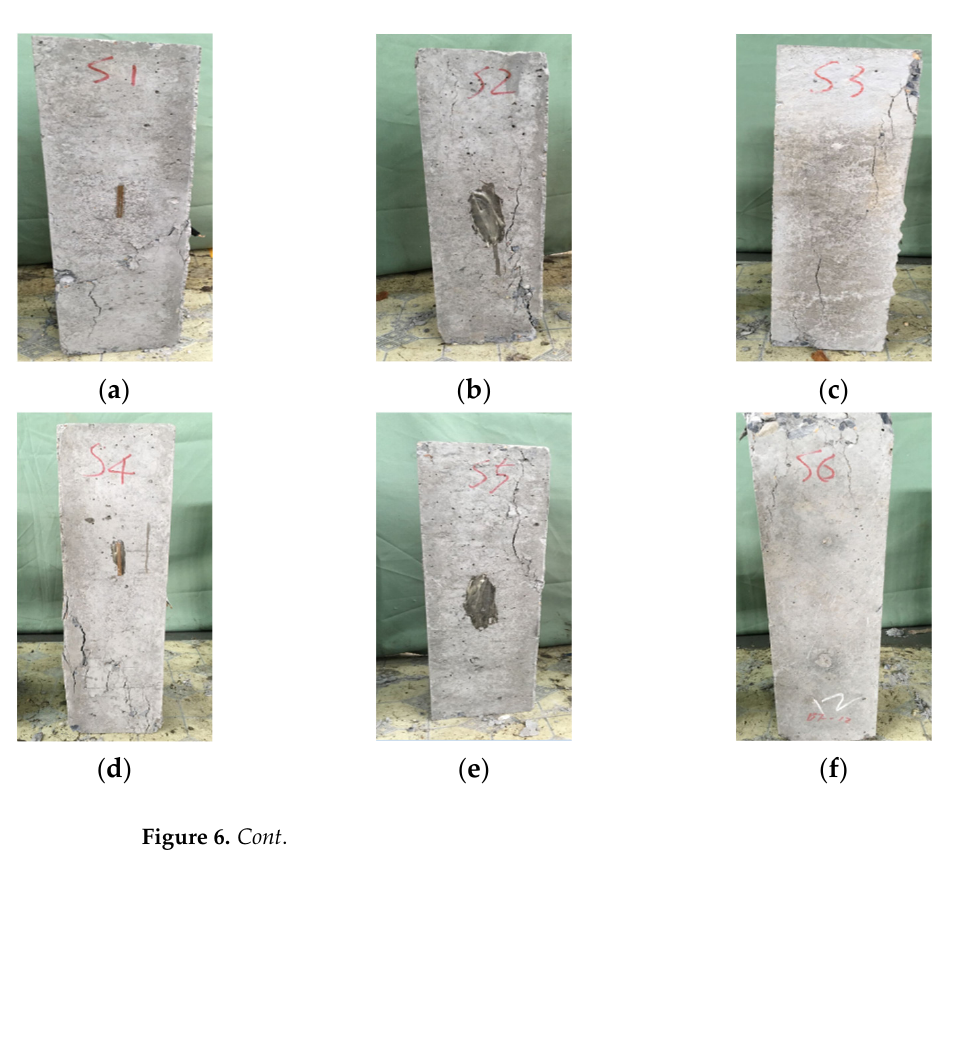
Figure 5. The reinforcement of the short column.